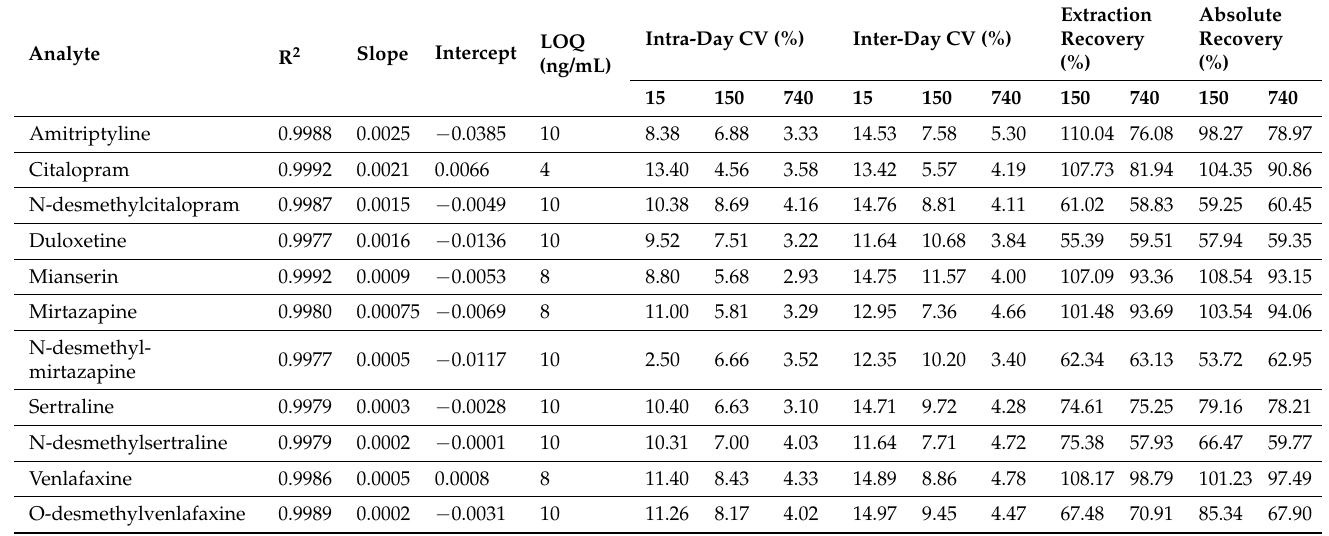
Table 2. Calibration curves (linearity in the range 10–1000 ng/mL) and validation parameters for the developed method.